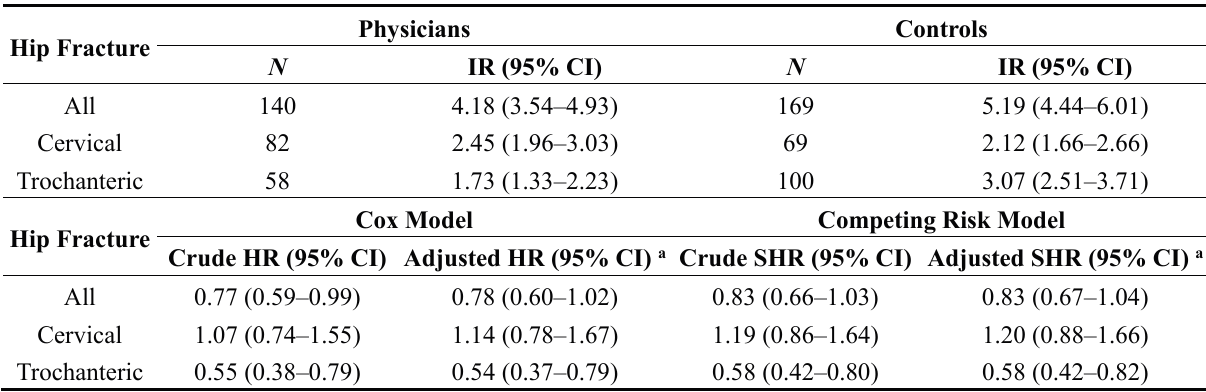
Table 2. Incidence rates (IR, per 1000 person-years) and hazard ratios of hip fracture in older physicians and controls ( n = 4303 in each group),